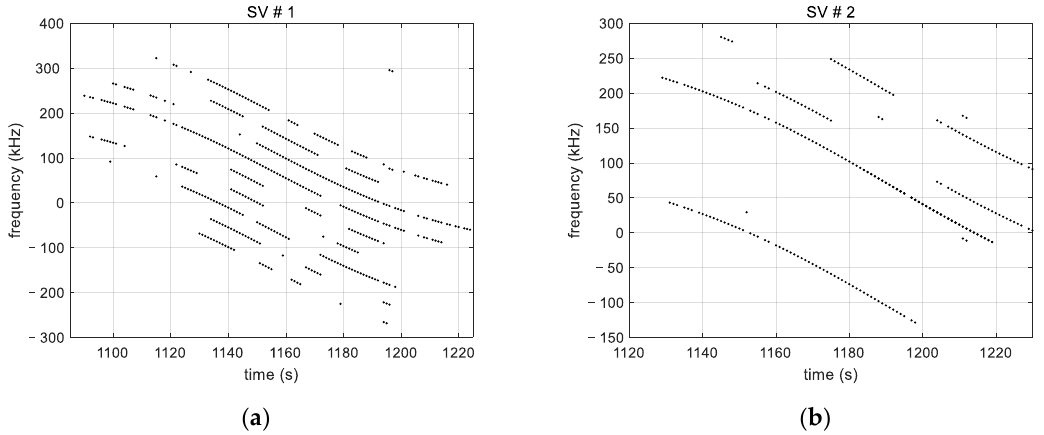
Figure 8. ( a ) Measured tone frequencies for satellite SV#1; ( b ) Measured tone frequencies for satellite SV#2, showing the difference in the number of tones tracked as well as the intermittent tracking. The latter is due to the low signal strength and the oscillating magnitude of the tones over time. The interruptions do not occur at the same time for tones of the same satellite because they have different amplitudes.